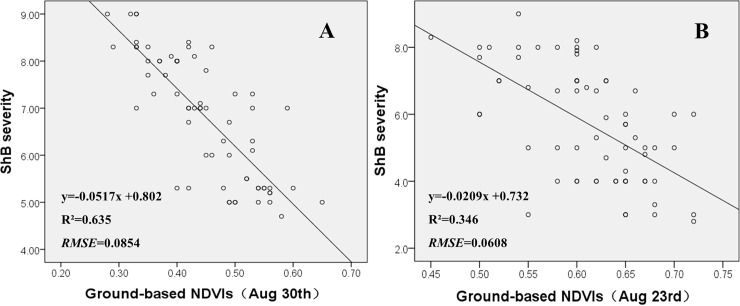
Correlations between ground-based NDVIs and ShB severity on Aug 30th (A) and Aug 23rd (B).